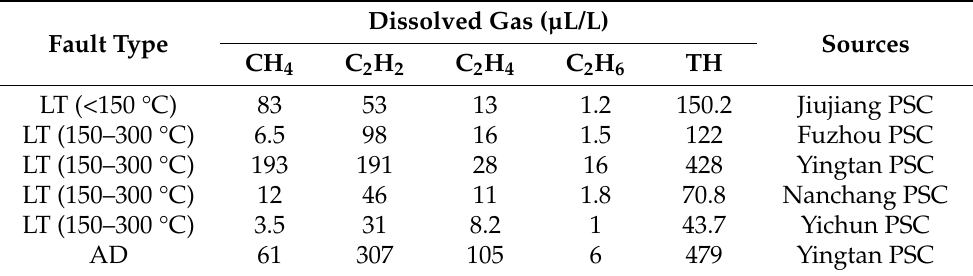
Table 1. Some real data from power supply companies in some provinces of China diagnosing power transformer fault types by DGA method.